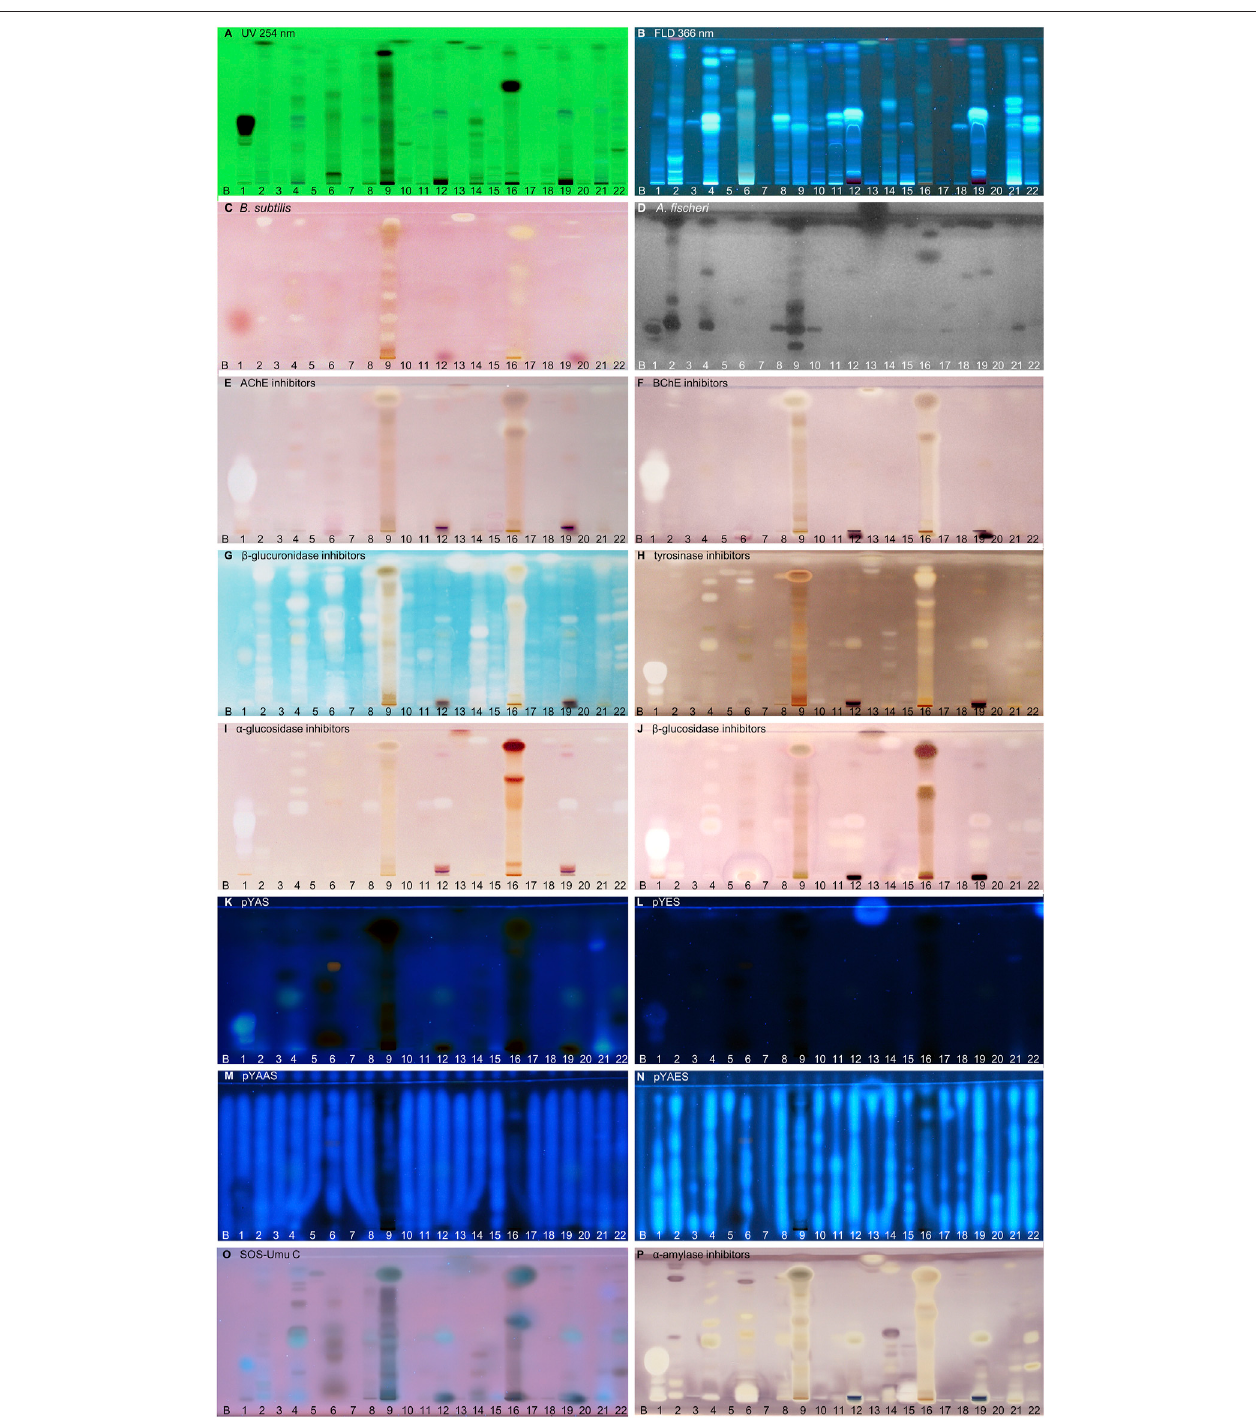
FIGURE2| NP-HPTLC − UV/Vis/FLD − EDApro fi lesoftheplantextractsno.1 – 22.Separationoftheappliedbotanicals(4µL/band,assignmentsin Table1 ;solvent blank B for comparison) on HPTLC plate silica gel 60 F 254 MS-grade with ethyl acetate — toluene — formic acid — water (16:4:3:2, V/V/V/V ) up to 70 mm, detected at UV 254 nm (A) , FLD 366 nm (B, K – O) and white light illumination (C, E – J, P) after the B. subtilis bioassay (C) , A. fi scheri bioassay with bioluminescence depicted as a greyscaleimage, (D) andAChE (E) ,BChE (F) , β -glucuronidase (G) ,tyrosinase (H) , α -glucosidase (I) , β -glucosidase (J) and α -amylase (P) inhibition assays,aswell as pYAS (K) , pYES (L) , pYAAS (M) , pYAES (N) , SOS-Umu-C (O) bioassays.